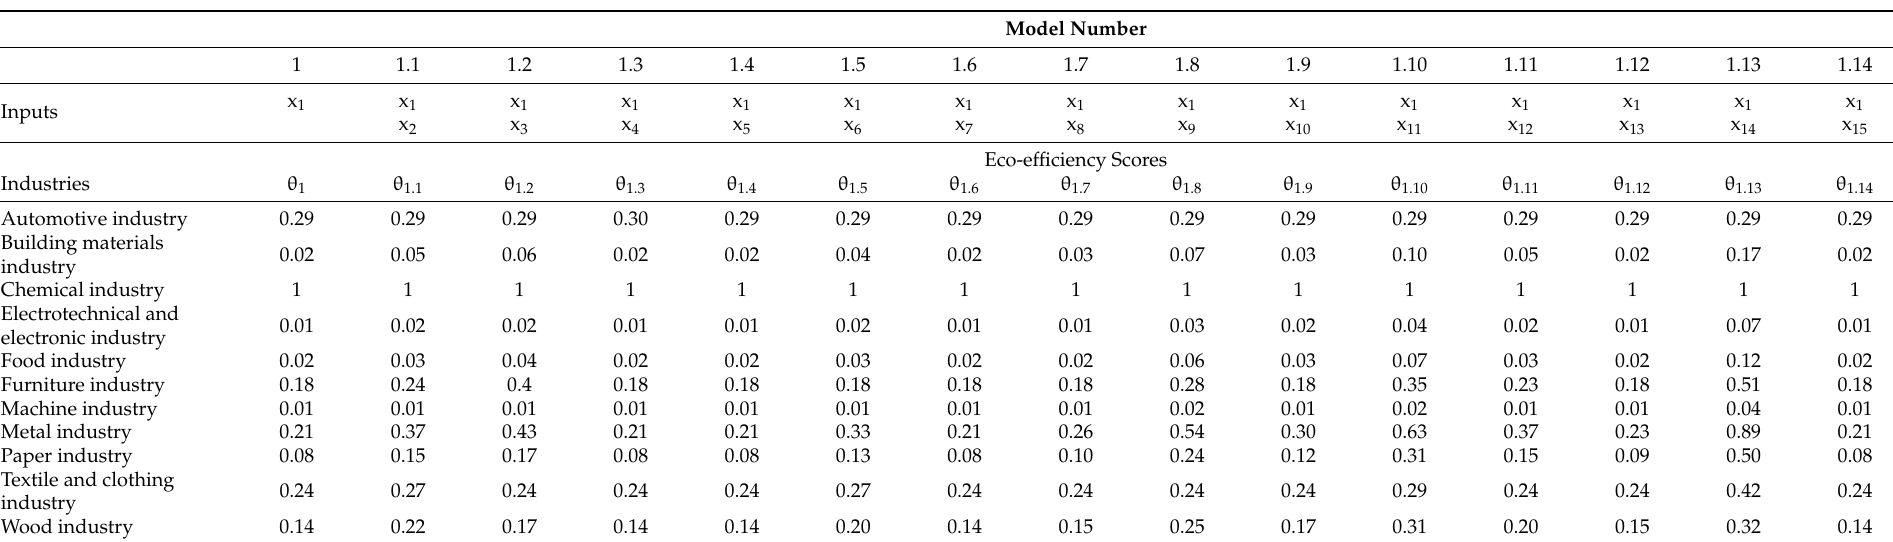
Table 1. Eco-efficiency scores obtained from the full models 1.1–1.14 and the reduced model